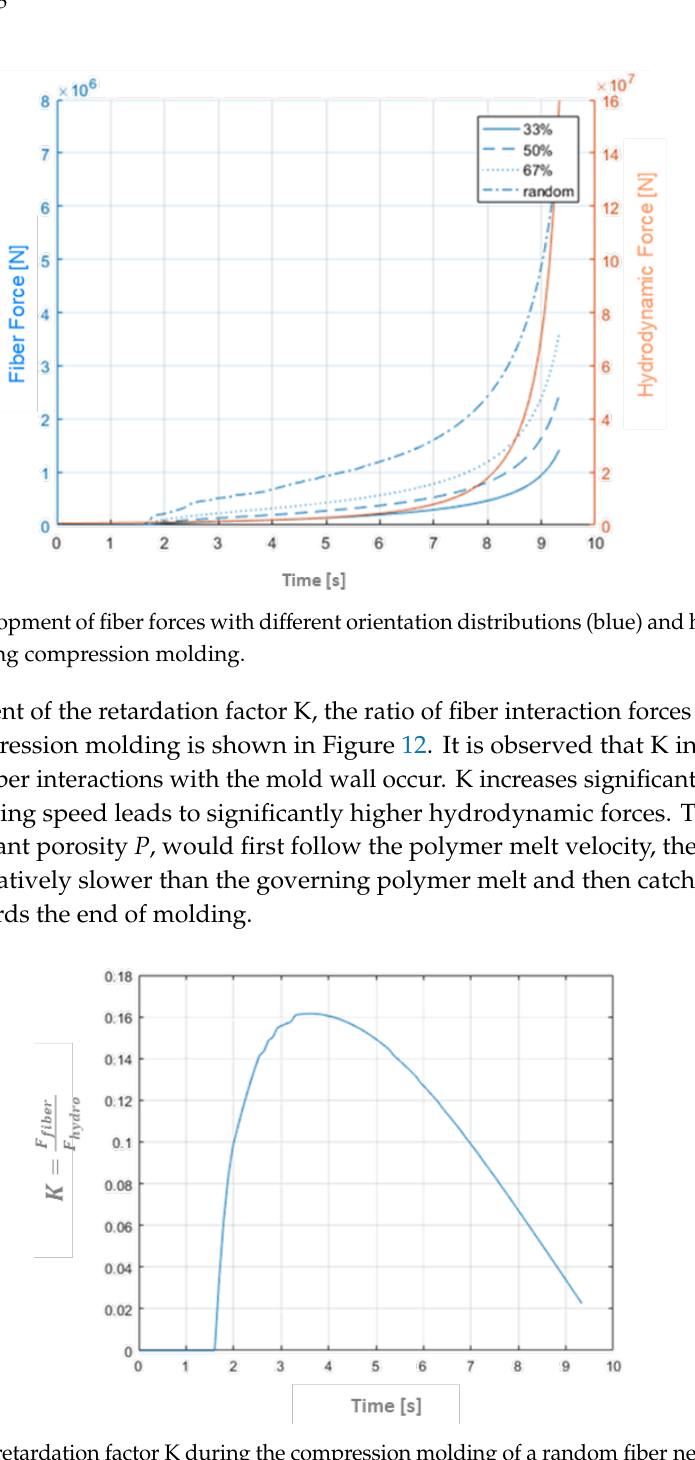
Figure 12. Fiber retardation factor K during the compression molding of a random fiber network ϕ = 0.4 .